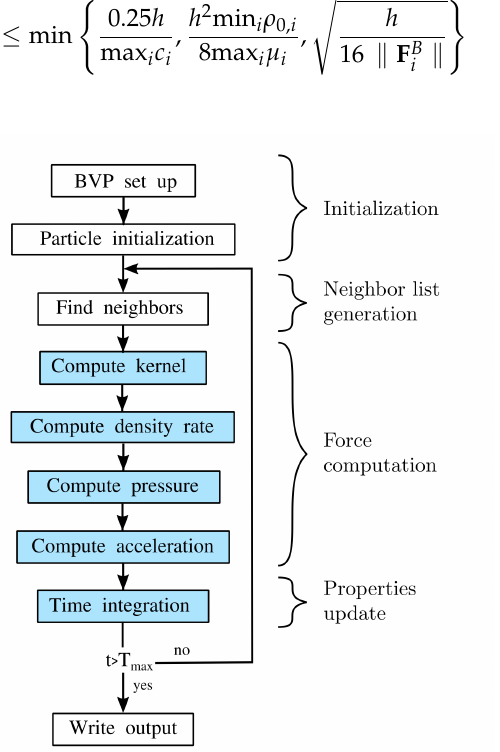
Figure 4. Workflow of SPH implementation. Blue background indicates own implementation within the HOOMD-blue library